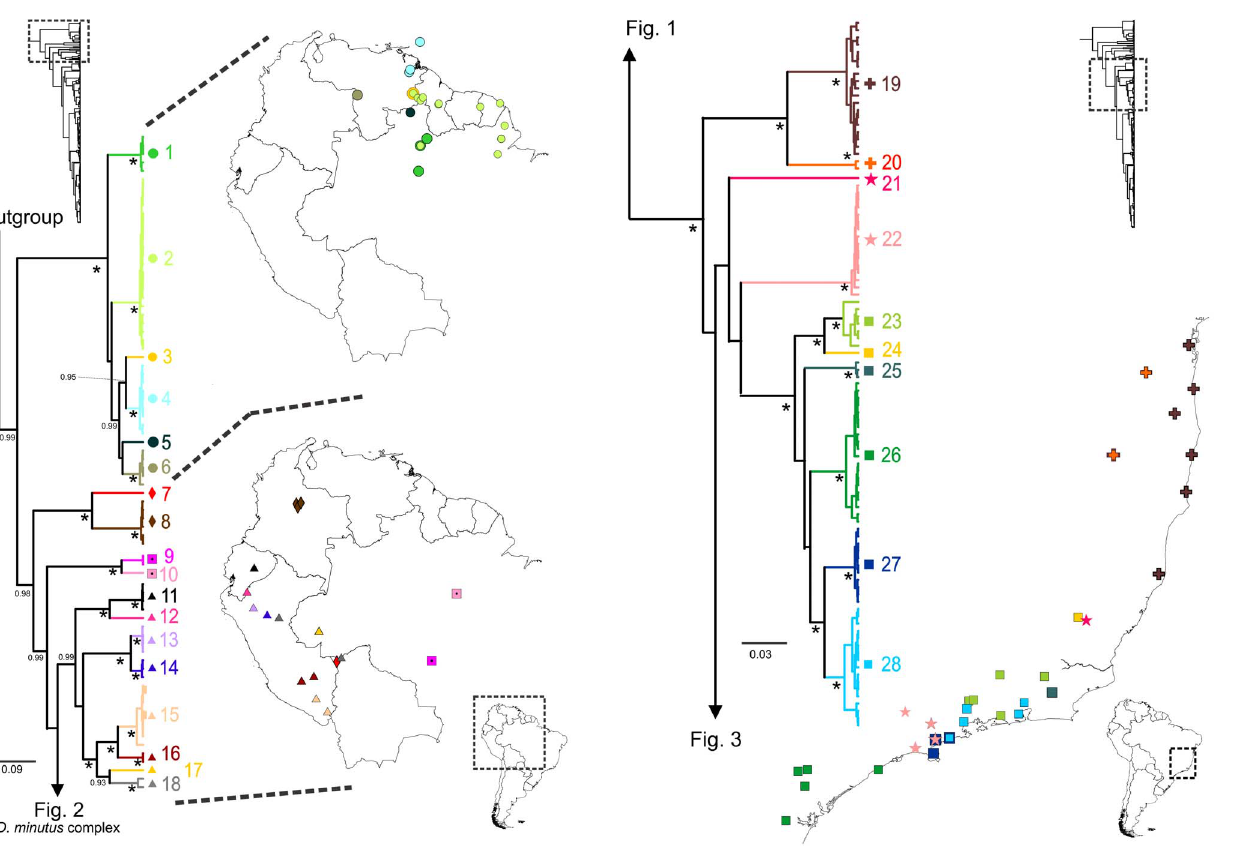
Figure 2. Dendropsophusminutus tree with lineage distribution part 2. 50% Maximum Clade Credibility tree and distribution maps of mtDNA lineages 19–28. Asterisks represent nodes with probability equals to 1. Probabilities lower than 0.9 are not